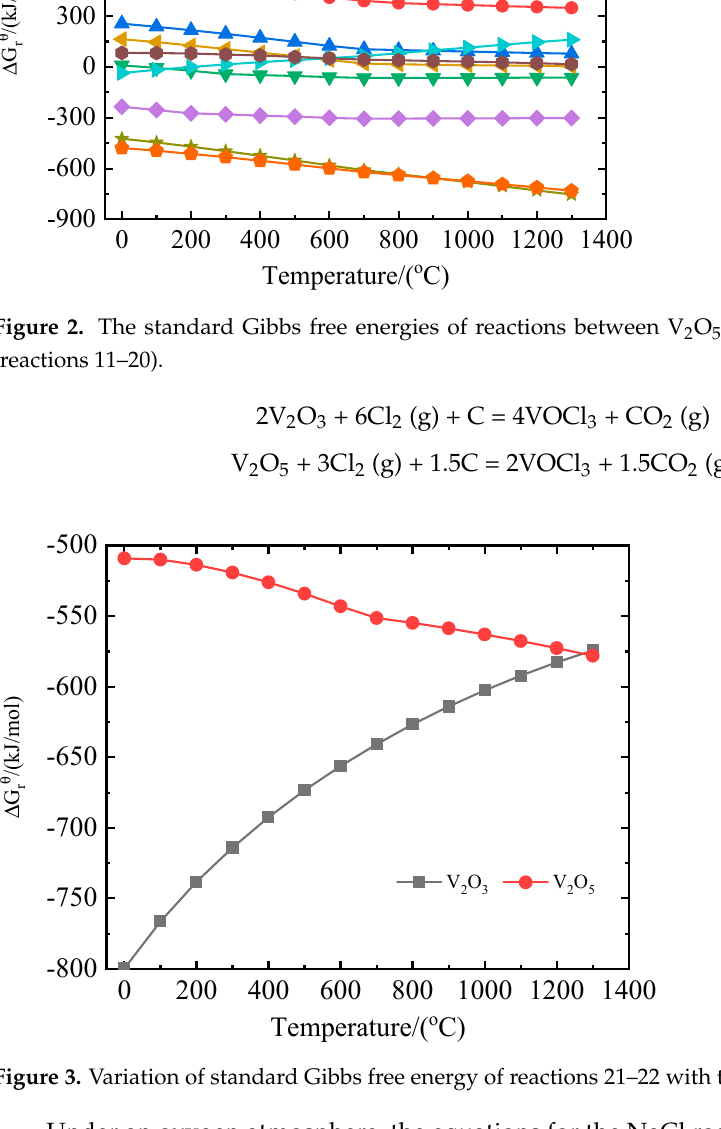
can be chlorinated by FeCl 2 and FeCl 3 under an oxygen atmosphere.